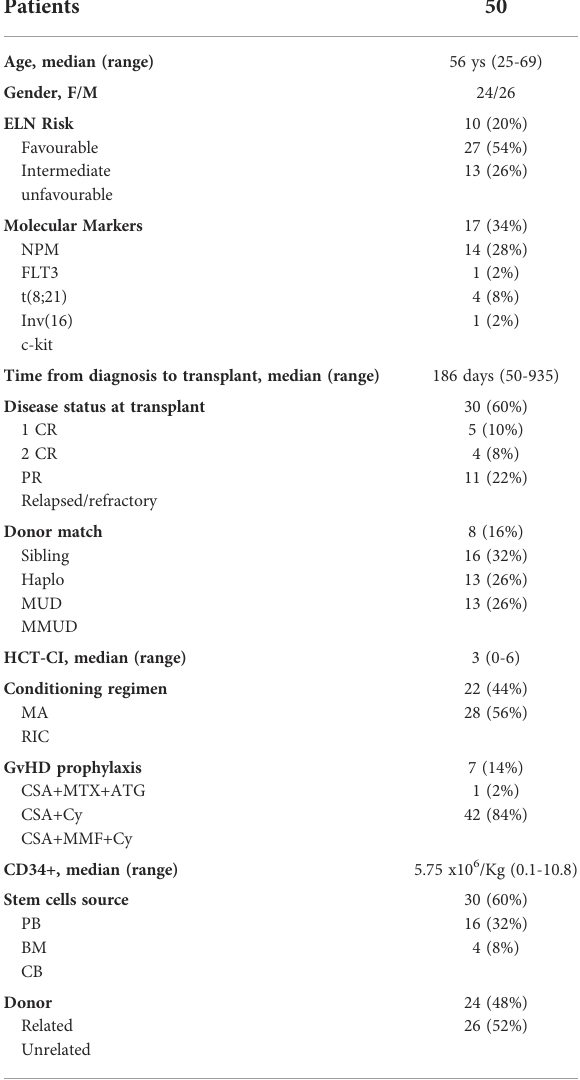
TABLE 1 Patient ’ s characteristics.